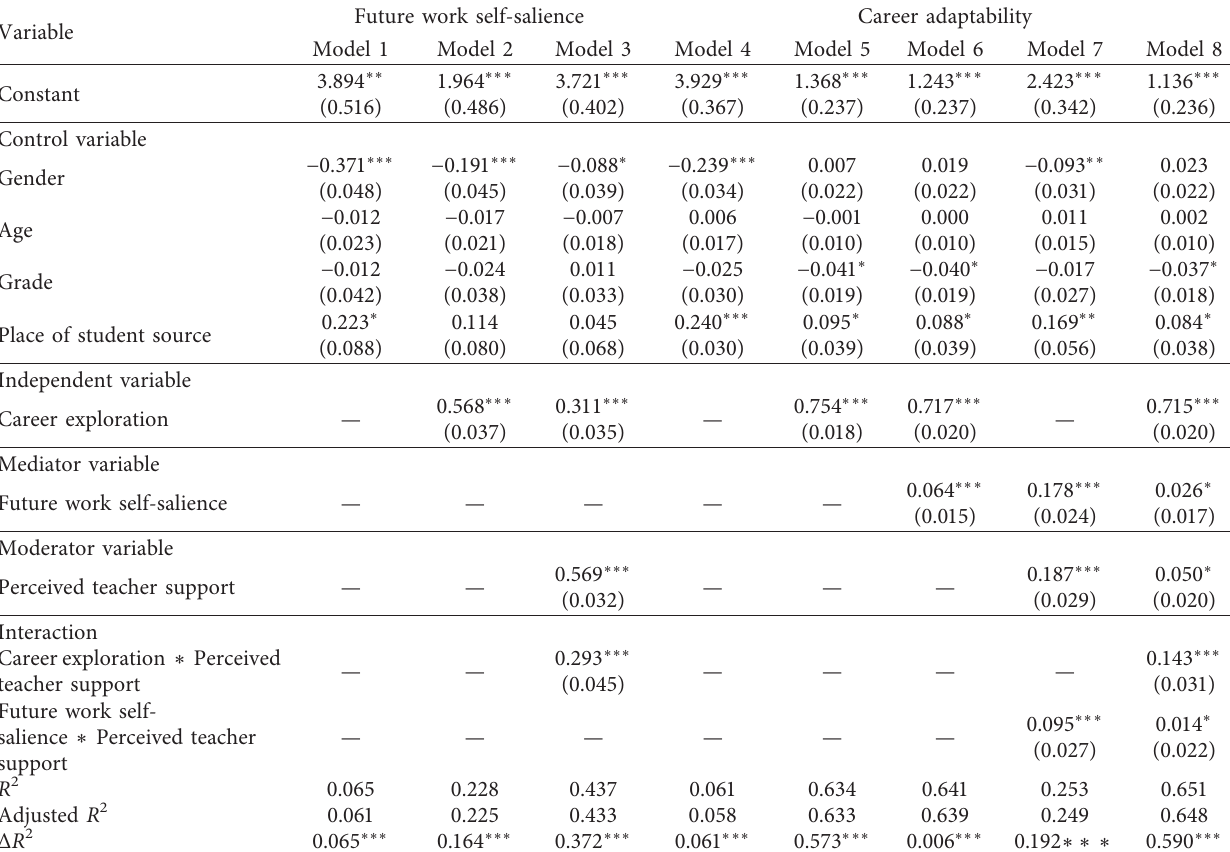
Table 3: Hierarchical regression analysis